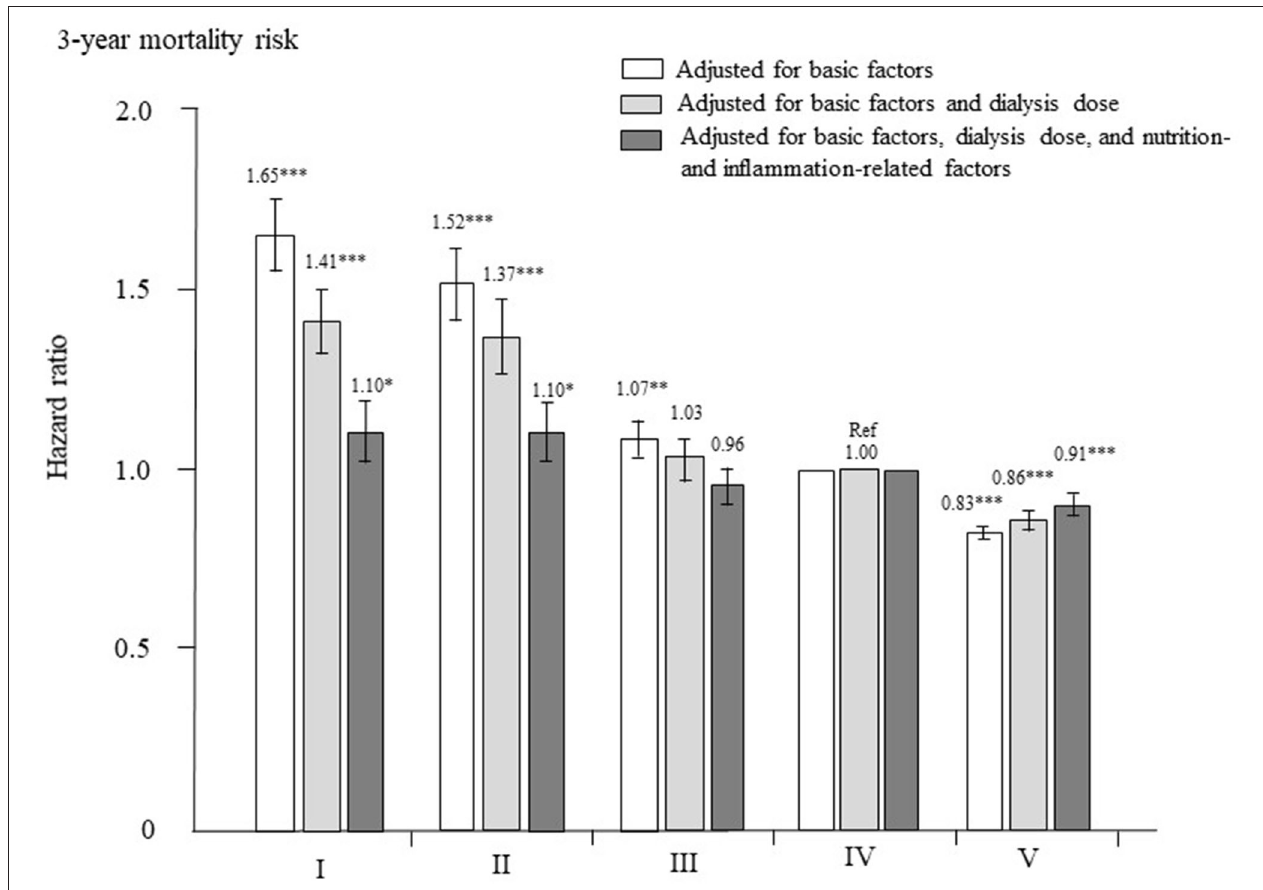
FIGURE 5 | Hazard ratios for all-cause mortality among the five dialyzer types in 238,321 patients undergoing hemodialysis, determined using standard Cox proportional hazards regression. White bars are adjusted for basic factors, including age, sex, dialysis vintage, presence/absence of diabetes mellitus, and presence/absence of cardiovascular complications. Gray bars are adjusted for dialysis dose, as assessed by Kt/V and β 2 -microglobulin levels, in addition to basic factors. Dark gray bars are adjusted for basic factors, dialysis dose, and nutrition- and inflammation-related factors, including body mass index, levels of C-reactive protein, hemoglobin, calcium, phosphate, intact parathyroid hormone, and serum albumin, normalized protein catabolic rate, and percent creatinine generation rate. * P < 0.05, ** P < 0.01, *** P < 0.0001 vs. the type IV dialyzer group (reference). Error bars correspond to 95% confidence